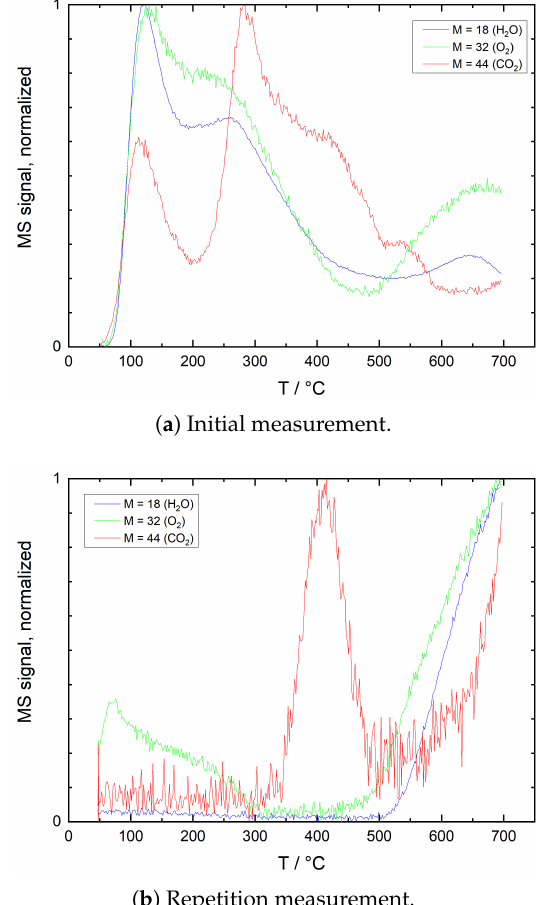
Figure 7. TPD plots of ITO powder in He, showing normalized mass spectrometer signals for mass numbers 32 (O 2 ), 18 (H 2 O) and 44 (CO 2 ). ( a ) Initial measurement after 1h of powder exposure to ambient air at room temperature, ( b ) repetition measurement after cooling to room temperature following the initial measurement, without changing gas